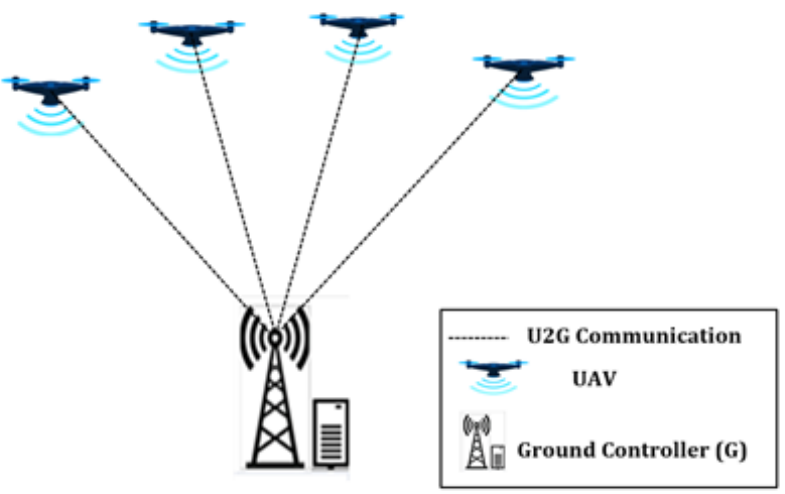
Figure 1. Non-interactive